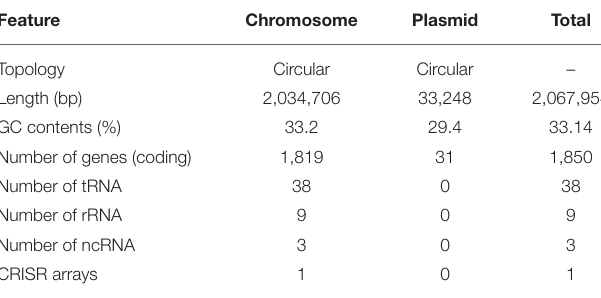
TABLE 1 | Genomic features of Helicobacter apodemus str.